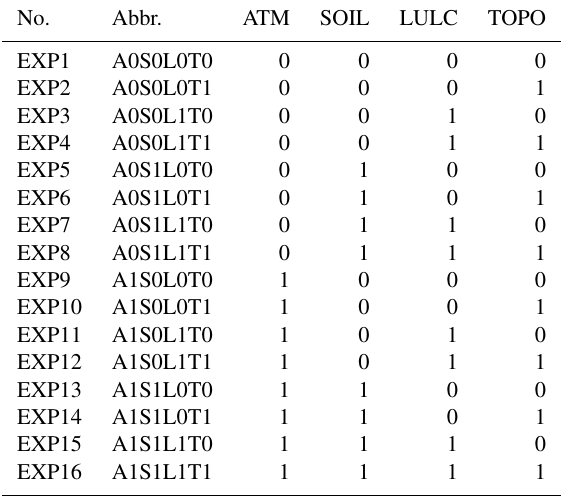
Table 2. The first set of 16 experiments with inputs from ATM, SOIL, LULC, and TOPO (0 and 1 denote homogeneous and hetero- geneous input from the four heterogeneity sources, respectively). No. Abbr.